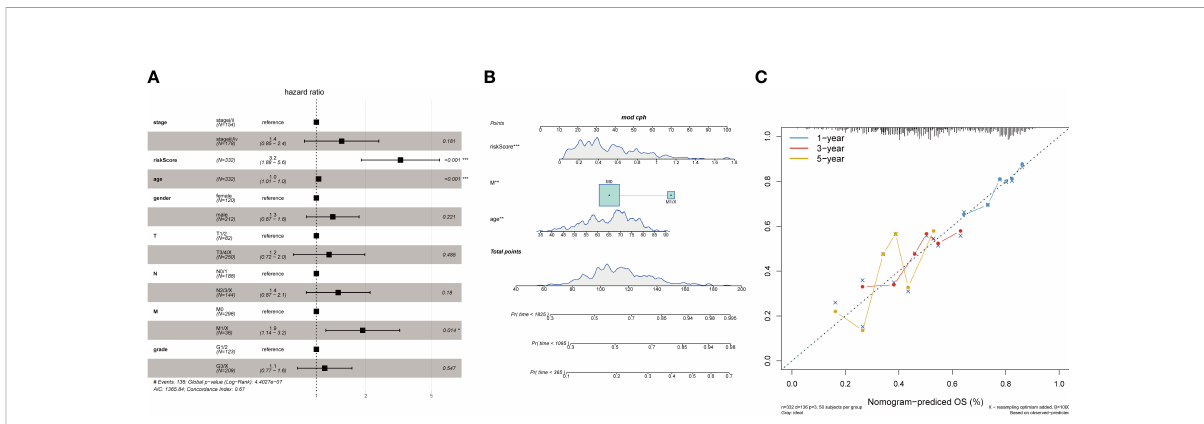
FIGURE 9 Association of tumor risk scores with clinical characteristics. (A) Multivariate Cox analysis of clinical features and risk scores; (B) Nomograms of clinical features and risk scores; (C) Nomograms for 1, 3, and 5